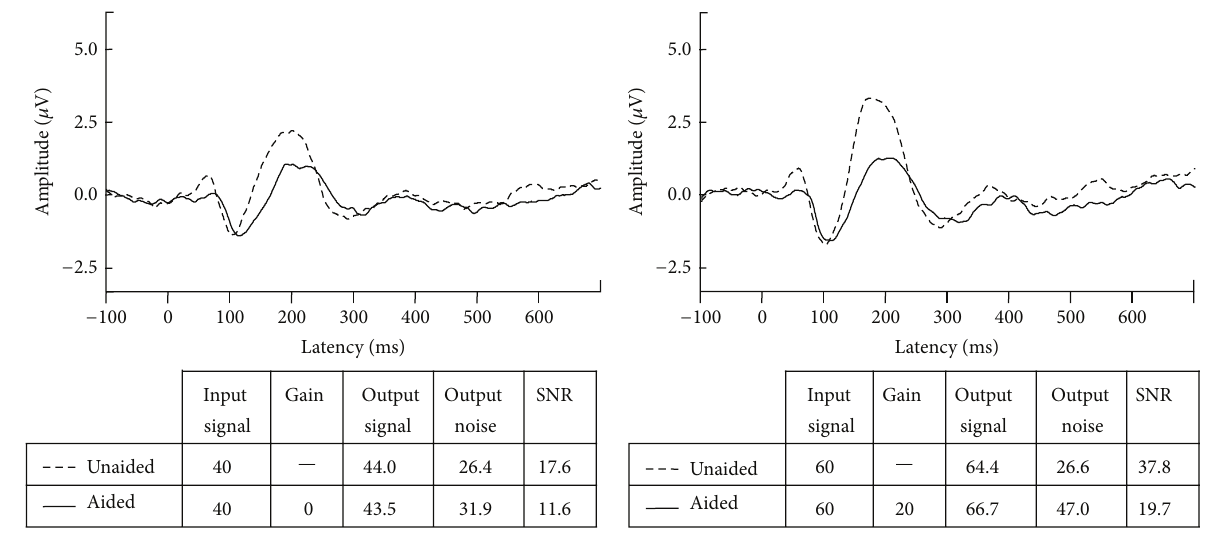
Figure 3: Two examples showing grand mean CAEPs recorded with similar mean output signal levels. Panels: (a) 40 dB input signals and (b) 60 dB input signals show unaided and aided grand mean waveforms evoked with corresponding in-the-canal acoustic measures. Despite similar input and output signal levels, unaided and aided brain responses are quite different. Aided responses are smaller than unaided responses, perhaps because the SNRs are poorer in the aided